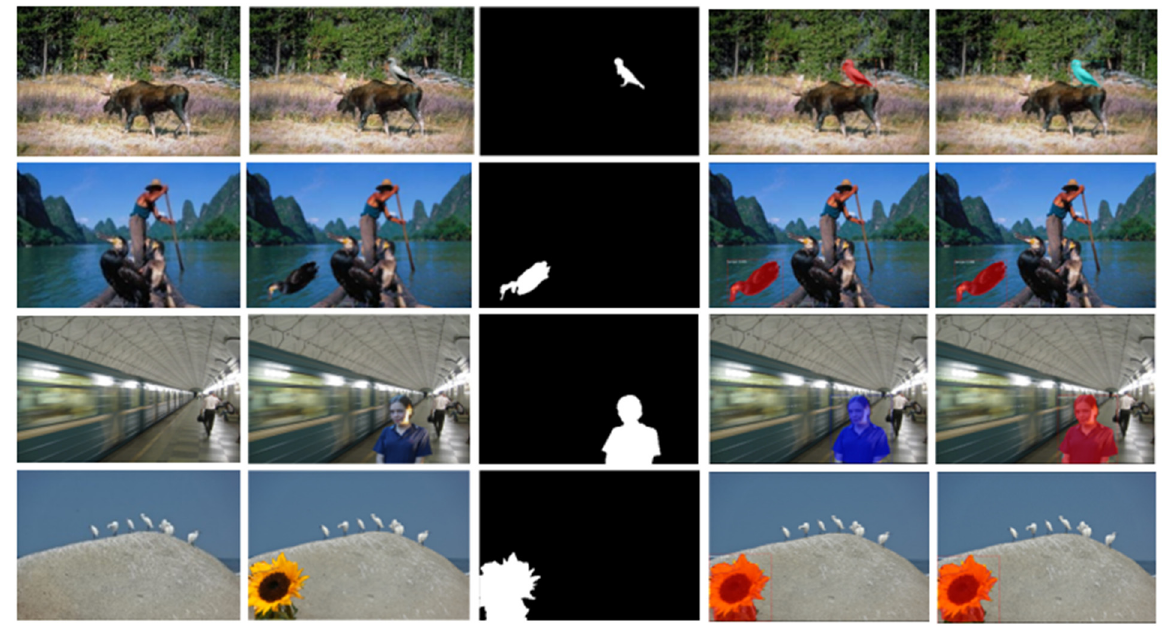
Figure 7. Examples of visual results on the CASIA and nist16 datasets. From left to right: the first three columns are original image, tampered images and Ground-Truth, the last two columns are the results of Ours (GE) and Ours (IIC).